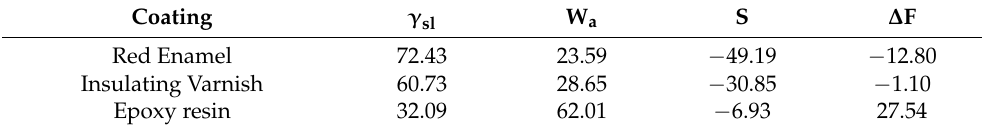
Table 4. Wetting parameters (mJ/m 2 ) calculated for red enamel, insulating varnish, and epoxy resin. Coating